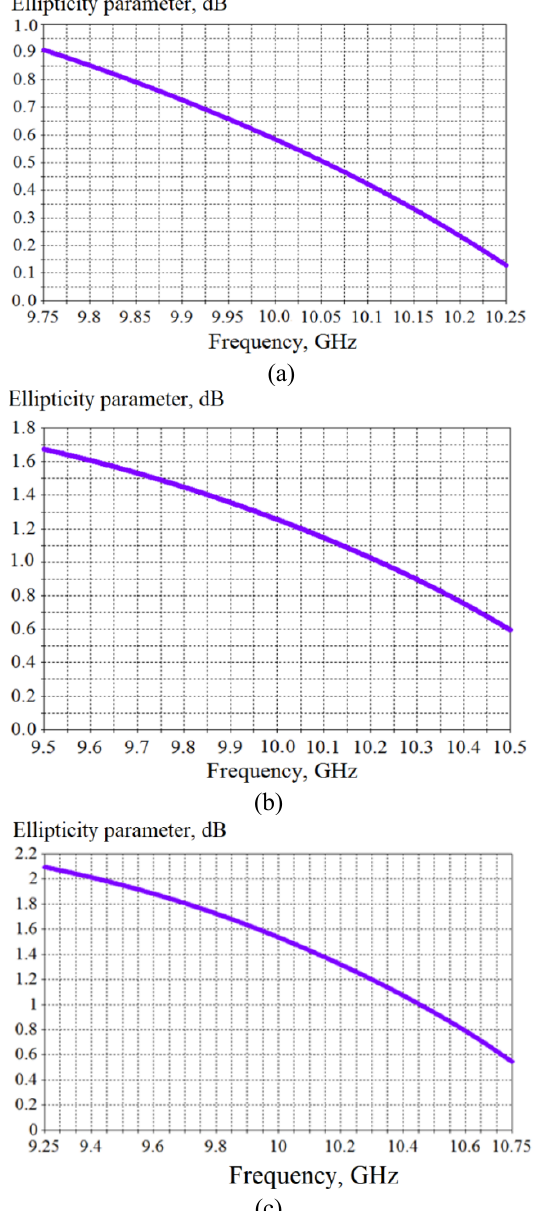
FIGURE 5. Dependences of ellipticity parameters of a septulum polarizer for different bandwidths: (a) 5% relative bandwidth; (b) 10% relative bandwidth; (c) 15% relative bandwidth.